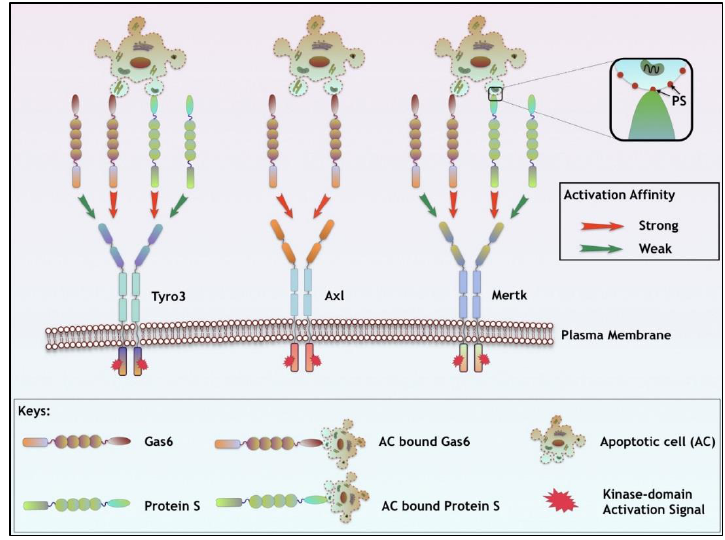
Figure 1. TAM receptor activation by Gas6, Pros1, and PS-positive apoptotic cells. TAM receptors exhibit differential activation by their ligands, Gas6 and Pros1. While Gas6 preferentially activates Axl and to lesser extent Tyro3 and Mertk; Pros1 does not activate Axl and is specific for Mertk and Tyro3. However, in the presence of externalized phosphatidylserine (PS) on the surface of apoptotic cells, stressed tumor vasculature, or PS- positive tumor exosomes, Gas6 and Pros1 mediated activation of TAMs is enhanced. After ligand binding, TAMs undergo subsequent dimerization and auto-phosphorylation of catalytic tyrosine kinase domain leading to downstream effector